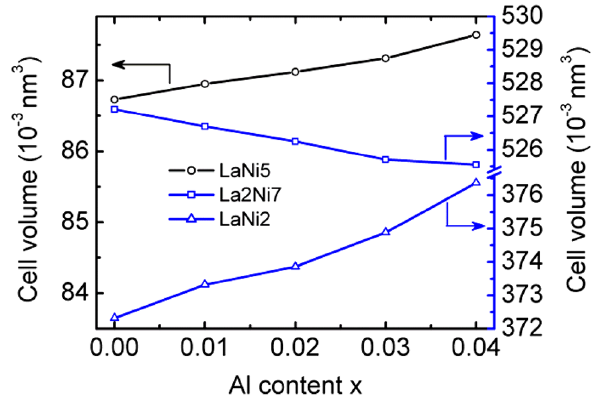
Fig. 2 Variation of cell volume